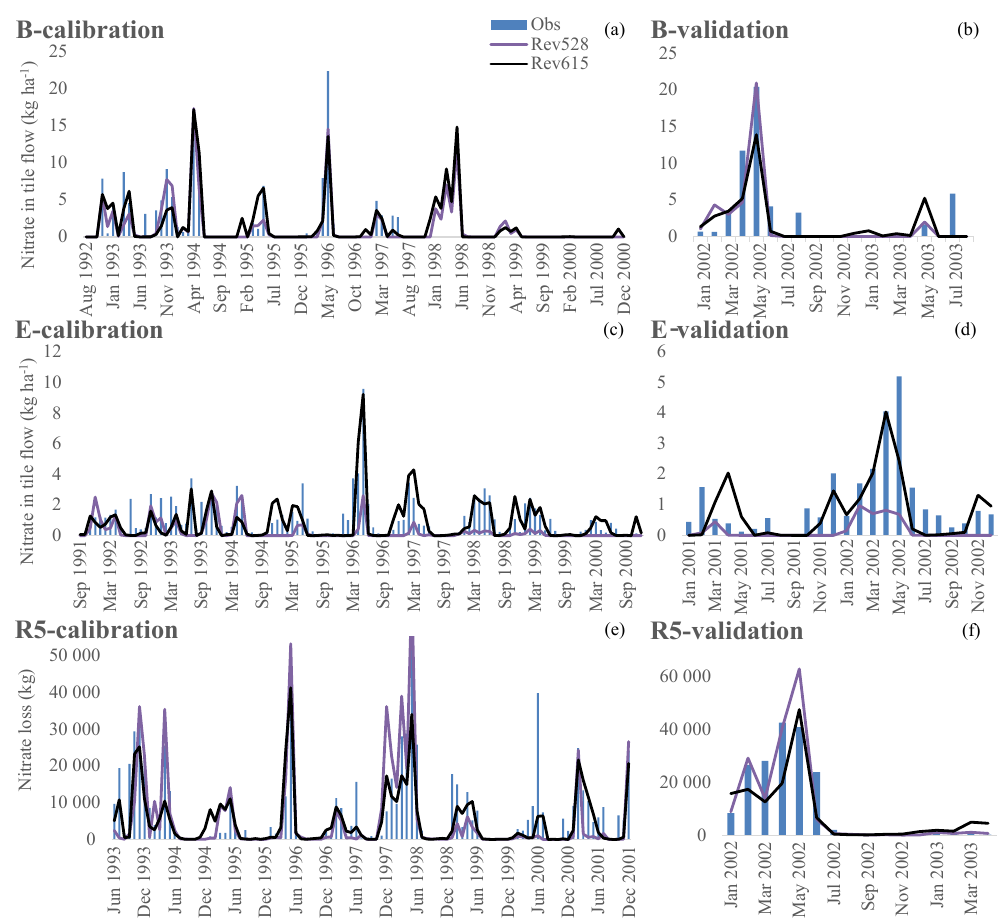
Figure 6. Calibration and validation results for monthly nitrate-nitrogen losses in tile flow at sites B (a, b) and E (c, d) , and monthly nitrate-nitrogen losses in flow at site R5 (e, f) . Obs, Revs. 528, and 615 represent Observed, Revision 528, and 615,